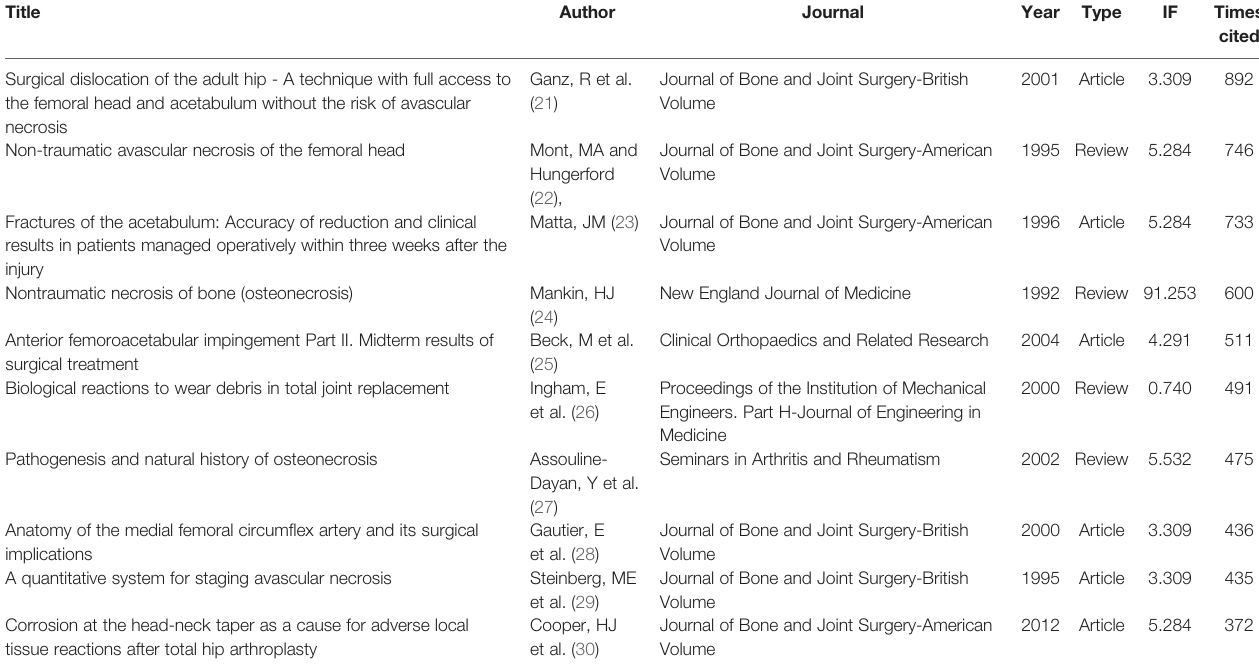
FIGURE 3 | Analysis of highly contributing journals and funding agencies in ONFH in the last 30 years. (A) Total publications, sum of times cited, average citations per item, and H-index of the top ten journals. (B) Total publications, sum of times cited, average citations per item, and H-index of the top ten funding agencies. TABLE 1 | Top ten most cited publications in osteonecrosis of femoral head (ONFH) in the